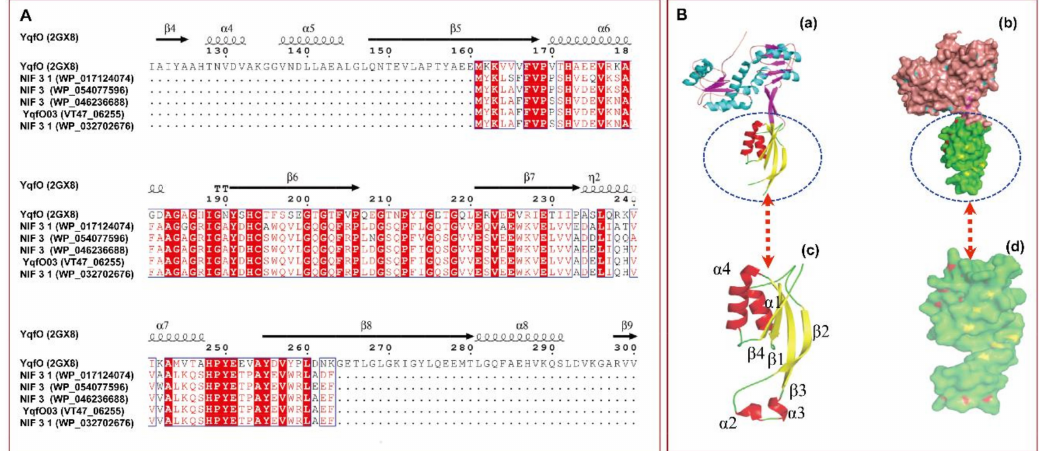
Figure 1. Sequence alignment of YqfO03 with several other Nif3-family proteins ( A ), and orthogonal and surface views of the ribbon and spatial structures of YqfO03 and B. cereus YqfO ( B ). In Figure 1A, sequence alignment with other Nif3 proteins, the additional Gen Bank accession numbers are given in parentheses; a tag number was used for YqfO03, and a PDB ID (2GX8) was used for YqfO. Secondary elements are shown above the alignment. Residues that are completely conserved are highlighted in solid red boxes. Those with similarity of >70% are labeled in red. The alignment was generated with the ClustalW2 program and used as the input for the ESPript program, Version 3.0 (http://espript. ibcp.fr/ESPript/cgi-bin/ESPript.cgi). In Figure 1B, homology model was built using 2GX8 as a 3D reference homolog model, ( a )/( b ): showing three-dimensional (3D) structure of YqfO; ( c )/( d ): YqfO03, showing similar parts both in orthogonal and surface views of the proteins. The colored α -helices (red) and β -sheet (yellow) constituting similar folds are shown in ( a , c ). The structural domains matching YqfO03 are indicated in the YqfO models by oval frames and